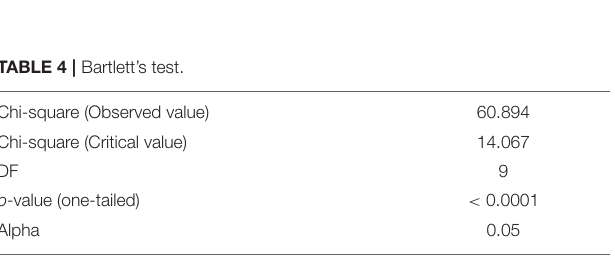
TABLE 4 | Bartlett’s